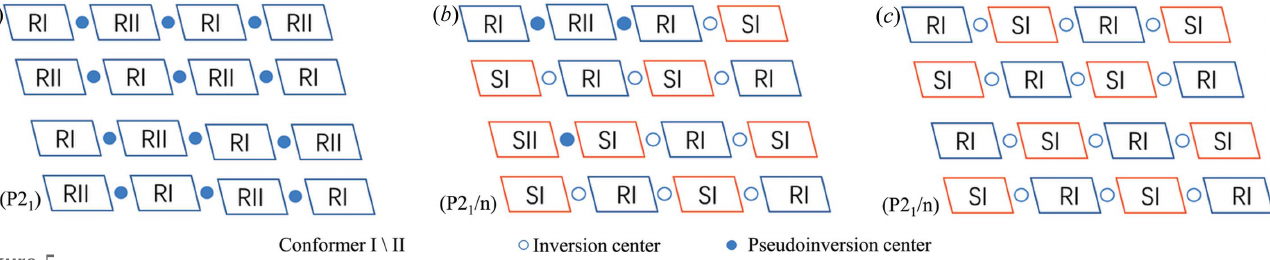
Figure 5 Graphical representation of the solid solution formation of the Rac -DMY–CAF cocrystal structure. ( a ) Enantiopure composition (note that the depicted inversion centers are not genuine, but only indicate a pseudosymmetry between coformers R I and R II). ( b ) Racemic composition as observed for most experimentally determined structures (statistical inversion centers). ( c ) Racemic composition as proposed by Chion et al. (1978) (genuine inversion